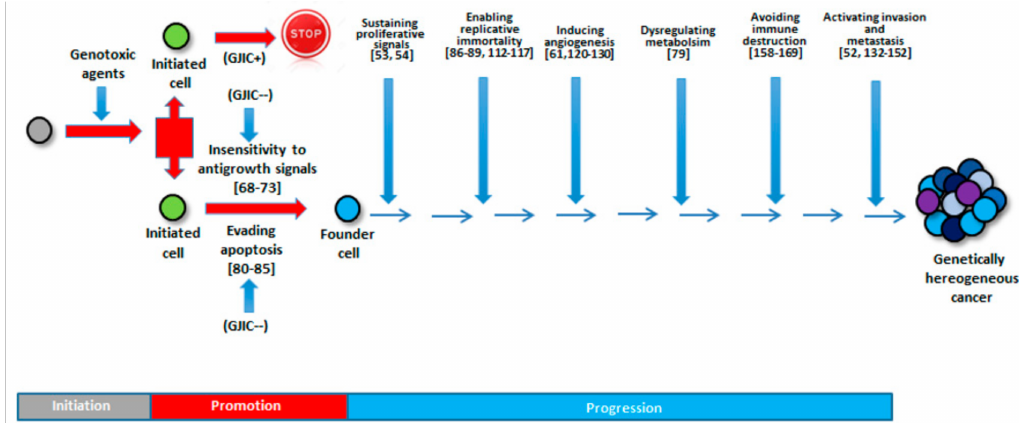
Figure 4. Involvement of GJIC in the di ff erent steps of carcinogenesis. Carcinogenesis is characterized by “initiation,” “promotion,” and “progression” phases. After a stem / progenitor cell is initiated by genotoxic agents, this is followed by promotion of cell growth. If functional GJIC is expressed, the initiated cell will be stopped at first step (Initiation). On the other hand, if these initiated cells are exposed, chronically, to agents that down regulate GJIC, they will lose sensitivity to antigrowth signals and evade apoptosis, giving rise to the so-called “founder” cell. During the progression phase, these cells would proliferate, accumulate, and accrue su ffi cient genetic / epigenetic changes that will allow them to acquire all the hallmarks of cancer. At the end, a tumor will be a mass of genetically heterogeneous cells. References showing the role of GJIC during all the described phases are indicated in square brackets. GJIC + : Gap Junction Intercellular Communication functioning; GJIC – : Gap Junction Intercellular Communication